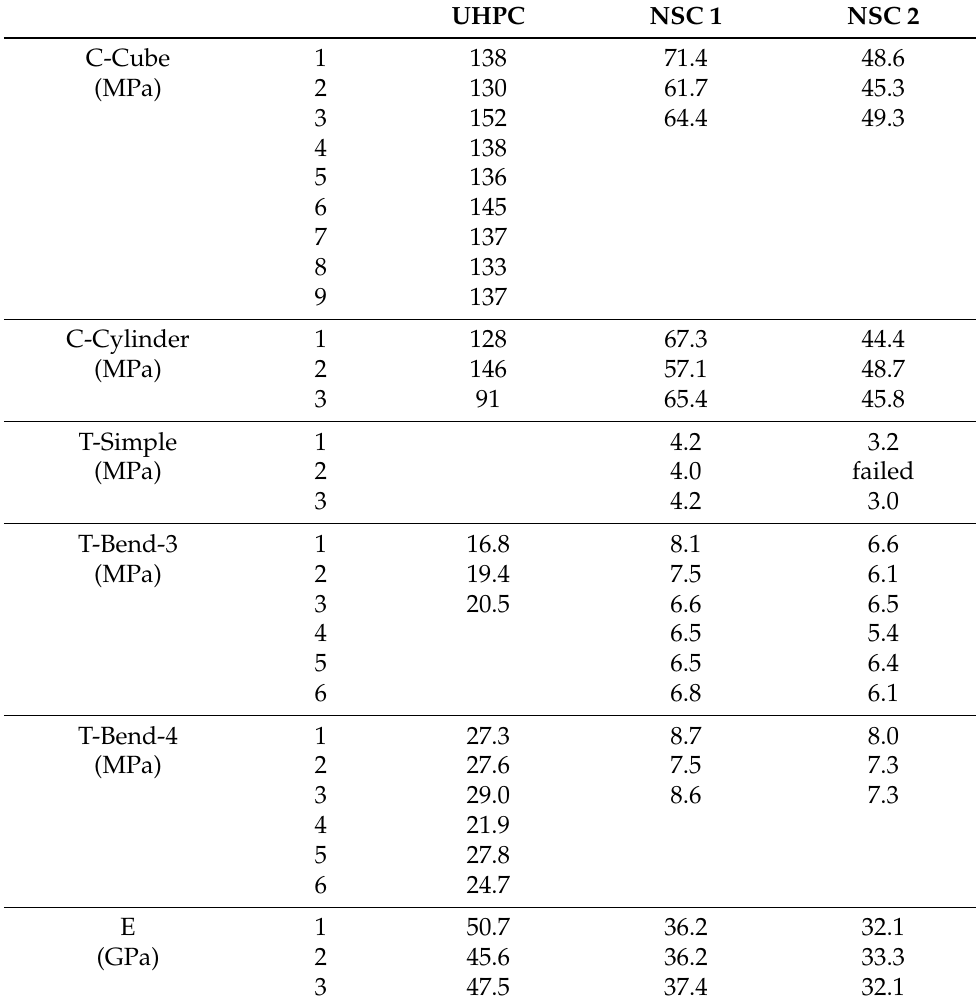
Table 2. Material parameters of UHPC and